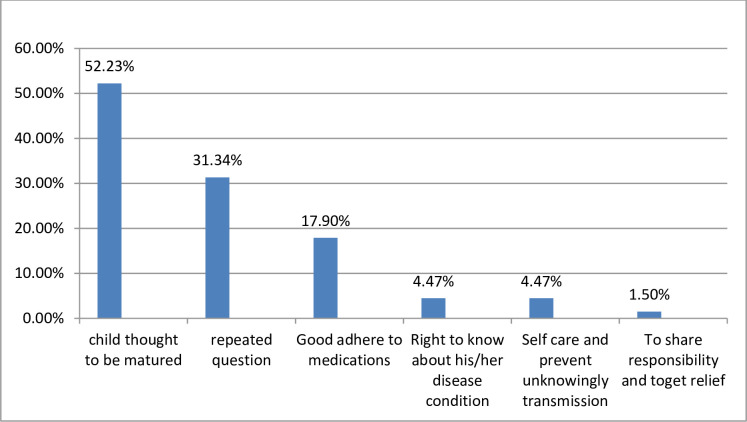
Caregivers reason for disclosing HIV-positive status to children LHIV+.